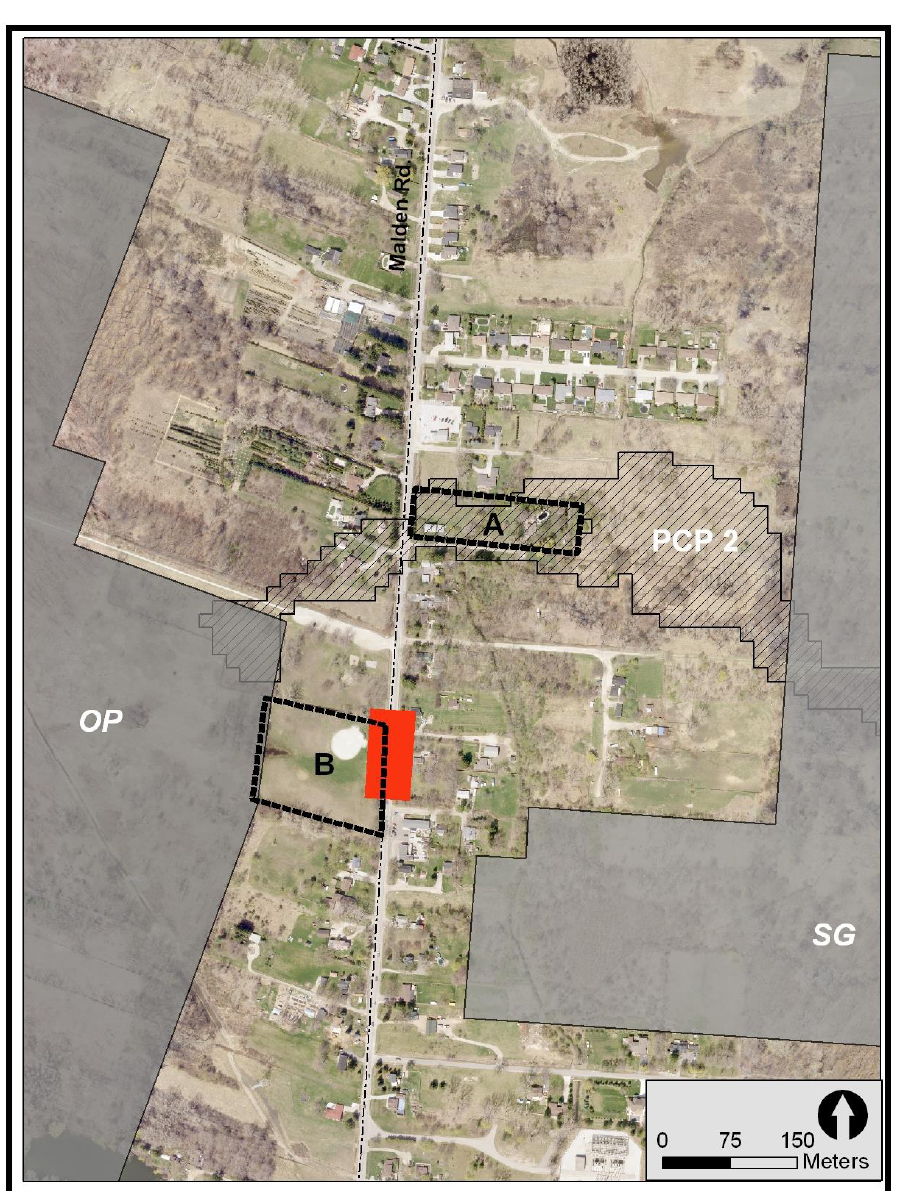
Figure 13. A possible explanation for the incongruence of PCP2 and the road segment with the highest number of snake road mortality records (red rectangle). Polygon A indicates a parcel of residential land use (urban pervious / impervious) that was erroneously classified as ‘naturalized open area’. Polygon B indicates a polygon of naturalized meadow (naturalized open area) that was classified as urban pervious. PCP2 is displayed at the 0.1% swath.